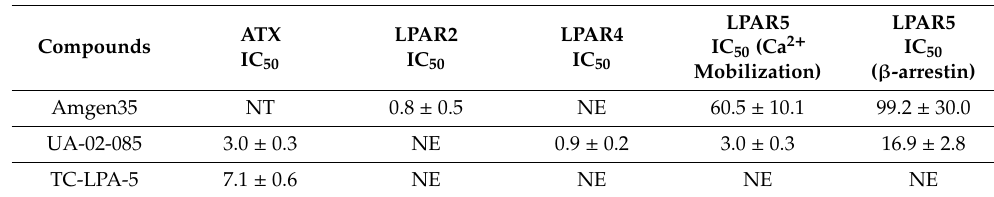
Table 2. Characterization of Amgen35, UA-02-085 and TC-LPA-5 compounds at LPAR2, LPAR4, LPAR5, and ATX. UA-02-085 and Amgen35 blocked LPA-induced Ca 2 + mobilization in LPAR5 expressing B103 cells and β -arrestin recruitment in LPAR5 expressing CHO-K1 cells. TC-LPA-5 had no e ff ect on all LPAR tested. Both UA-02-085 and TC-LPA-5 inhibited ATX activity measured using the fluorescent FS-3 substrate